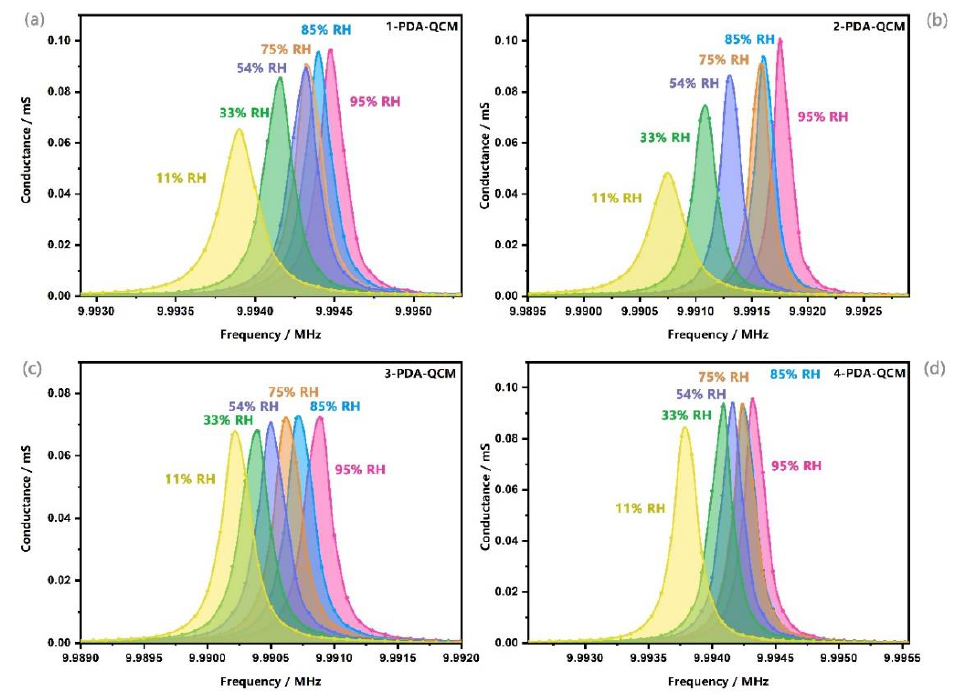
Figure 6. Admittance curves of ( a ) 1-PDA-QCM, ( b ) 2-PDA-QCM, ( c ) 3-PDA-QCM, and ( d ) 4-PDA-